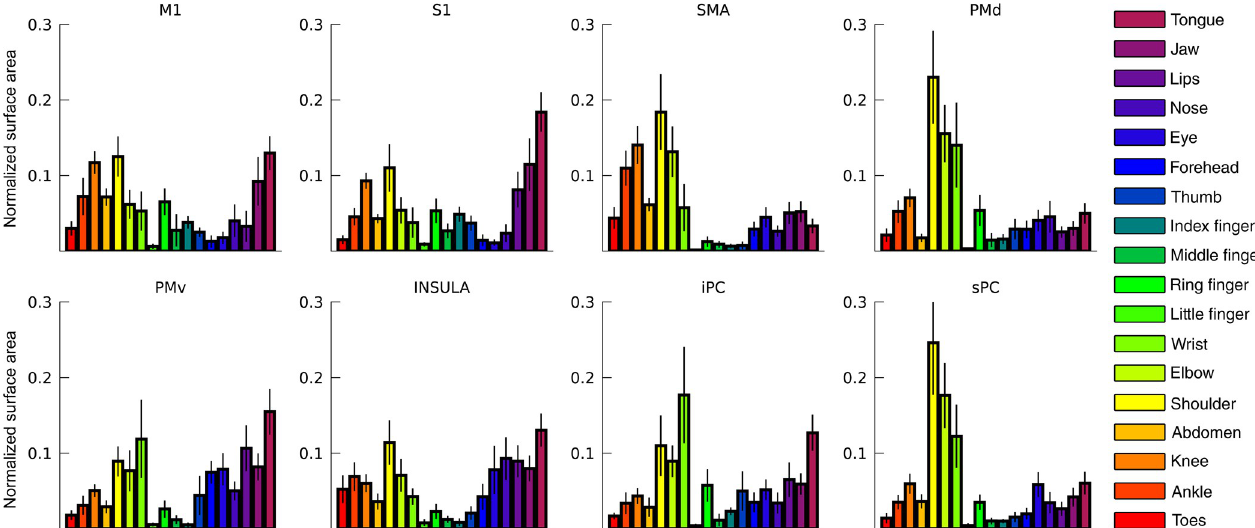
Fig 2. Surface area. For each included cortical area, the surface area as estimated by Freesurfer is shown per body part representation. The surface area is normalized to the total surface area of each cortical area. Body part representations are determined on the basis of the pRF center value. https://doi.org/10.1371/journal.pcbi.1009955.g002 part, somatotopic structures in the left (contralateral) hemisphere can be observed from both a lateral and medial point of view (Figs 3 and S4). Somatotopic structures are most prominent in M1 and S1, reflected by a significant gradual change in preferred body part along the direction of the central sulcus (i.e. pRF center gradients: t = 20.43, p < 0.001, and t = 126.77, p < (7) (7) 0.001, for M1 and S1 respectively). Evidence for somatotopic structures is also observed for